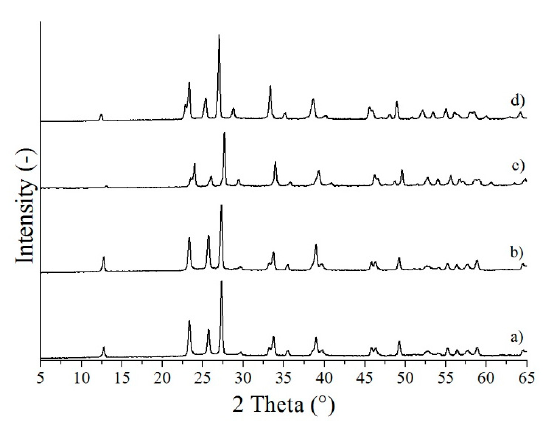
Figure 3. XRD patterns of the samples synthetized in the hydrothermal reaction of AHM and HNO 3 with various additives, ( a ) MoO 3 -7 (CTAB, 240 ◦ C, 3 h), ( b ) MoO 3 -8 (CTAB, 240 ◦ C, 6 h), ( c ) MoO 3 -9 (CrCl 3 , 240 ◦ C, 3 h), ( d ) MoO 3 -10 (CrCl 3 , 240 ◦ C, 6 h) .